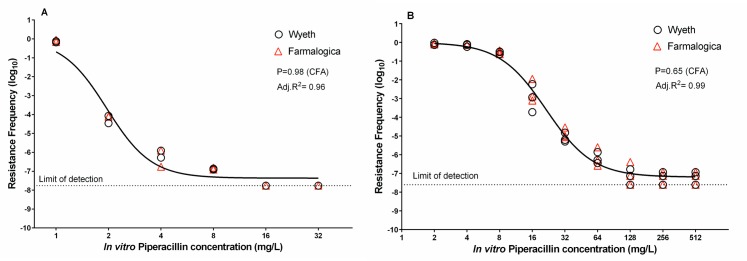
In vitro TZP population analysis profile (PAP) of E. coli ATCC 35218 and 35218R.TZP population analysis profile of E. coli ATCC 35218 (A) and E. coli 35218R (B). The resistance frequency data vs. TZP concentration was modelled using Hill’s equation and compared by CFA. There were no differences between innovator (Wyeth, black open circles) and generic (Farmalogica, red open triangles). Both data sets were better described by a single curve.